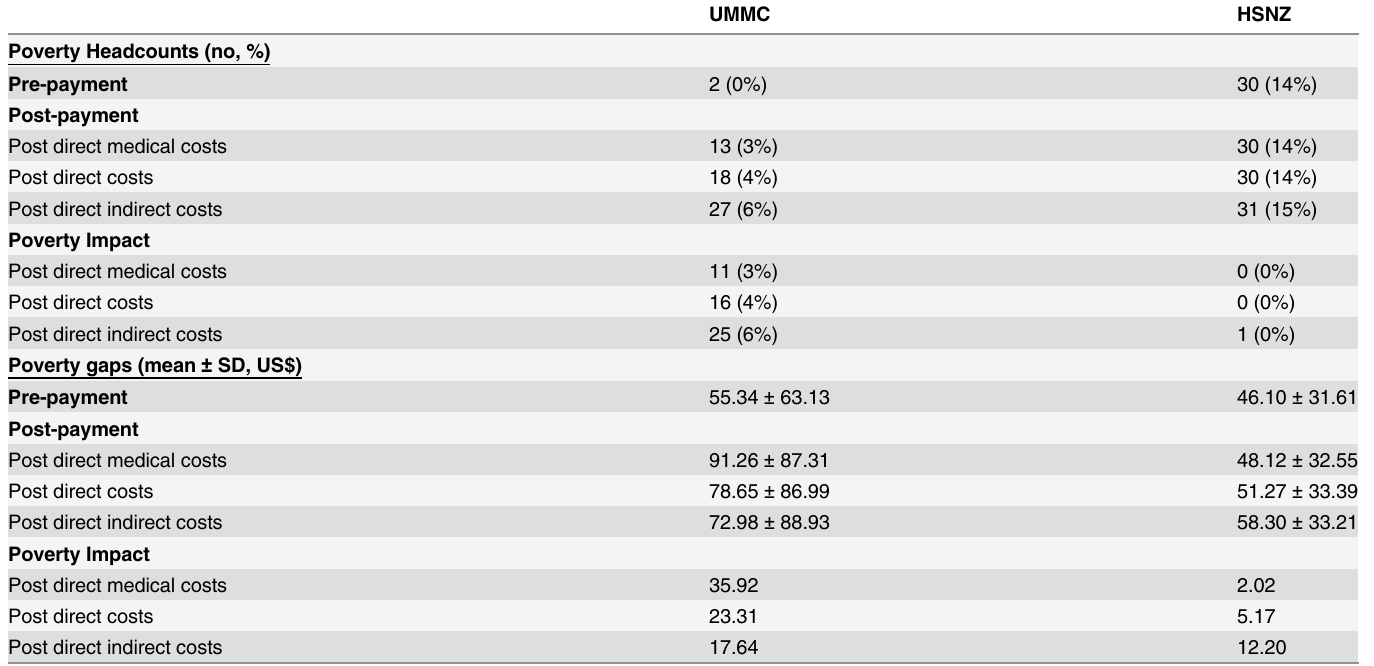
Table 3. Poverty Impact of hospitalization for acute gastroenteritis at UMMC, Kuala Lumpur and HSNZ, Kuala Terengganu. UMMC